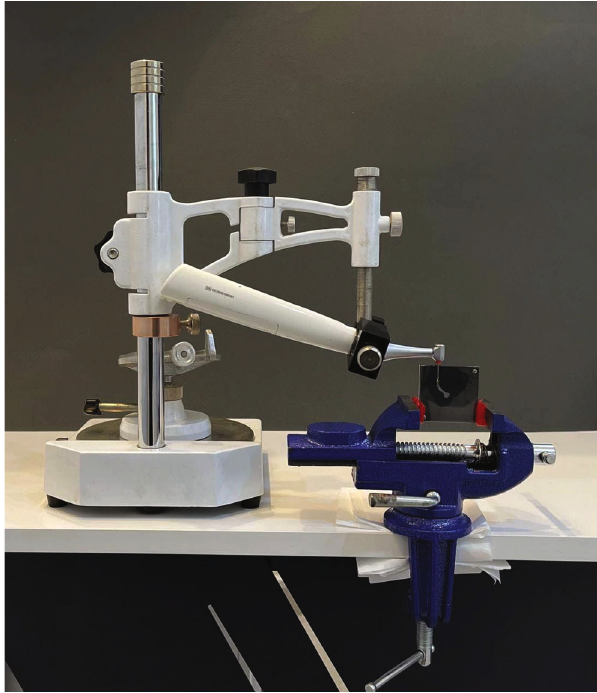
Figure 2: Dental handpiece fi xation on the dental surveyor.